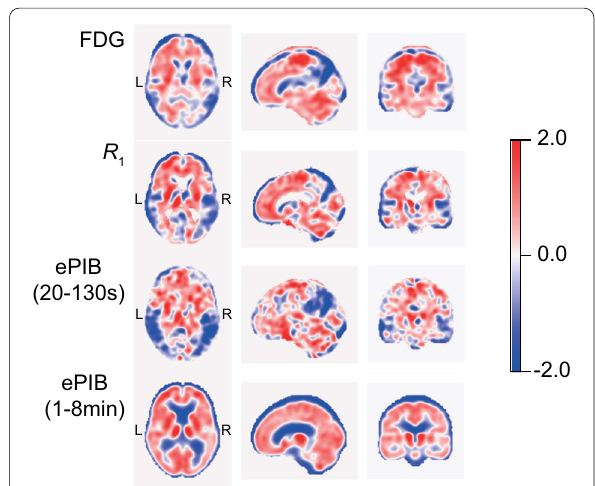
Fig. 1 Disease Patterns. AD-DPs results from the comparison between HC and AD patients for FDG (first row), R 1 (second row), ePIB(20–130 s) (third row), and ePIB(1–8 min) (fourth row). Blue and red colours indicate negative and positive voxel values, respectively. The closer to white, the closer the voxel value is to zero. All colour scales were adjusted to the same range